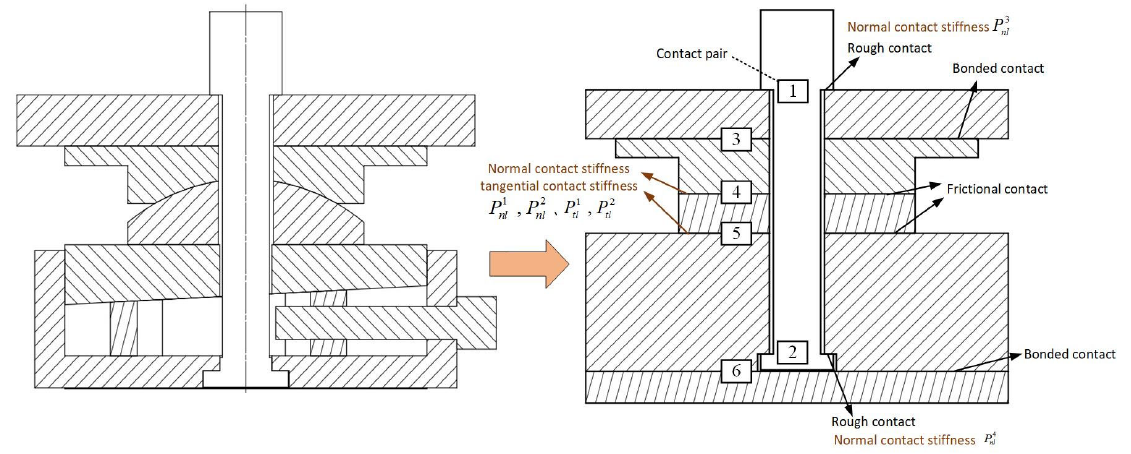
Figure 9. Schematic diagram of the contact pairs of a single three ‐ point leveling unit.